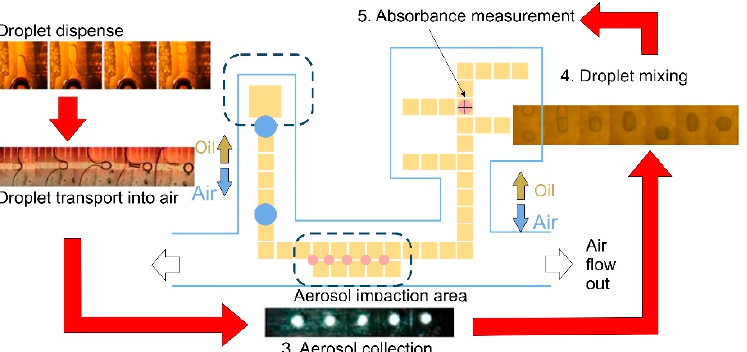
Figure 9. Schematic diagram of an electrowetting device for airborne PM analysis. Reproduced from Reference [166]. Copyright (2020) Molecular Diversity Preservation International under a